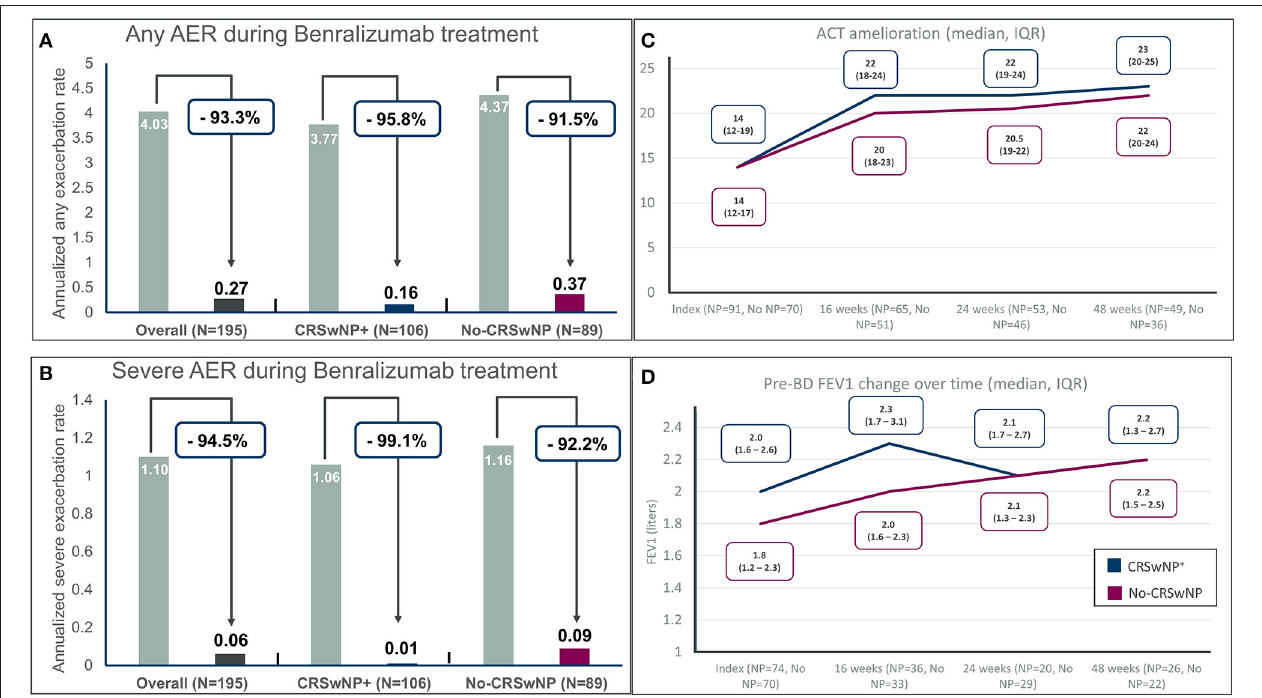
FIGURE 1 | Annualized exacerbation rates (AER) of any severity (A) and for severe exacerbations (B) during benralizumab treatment in the entire population and in severe eosinophilic asthma patients with and without chronic rhinosinusitis with nasal polyps (CRSwNP); (C) Asthma control test (ACT) improvement in different timepoints in severe eosinophilic asthma (SEA) patients with and without chronic rhinosinusitis with nasal polyps (CRSwNP); (D) Pre-BD FEV1 (pre-bronchodilator forced expiratory volume in the first second) change over time in severe eosinophilic asthma (SEA) patients with and without chronic rhinosinusitis with nasal polyps